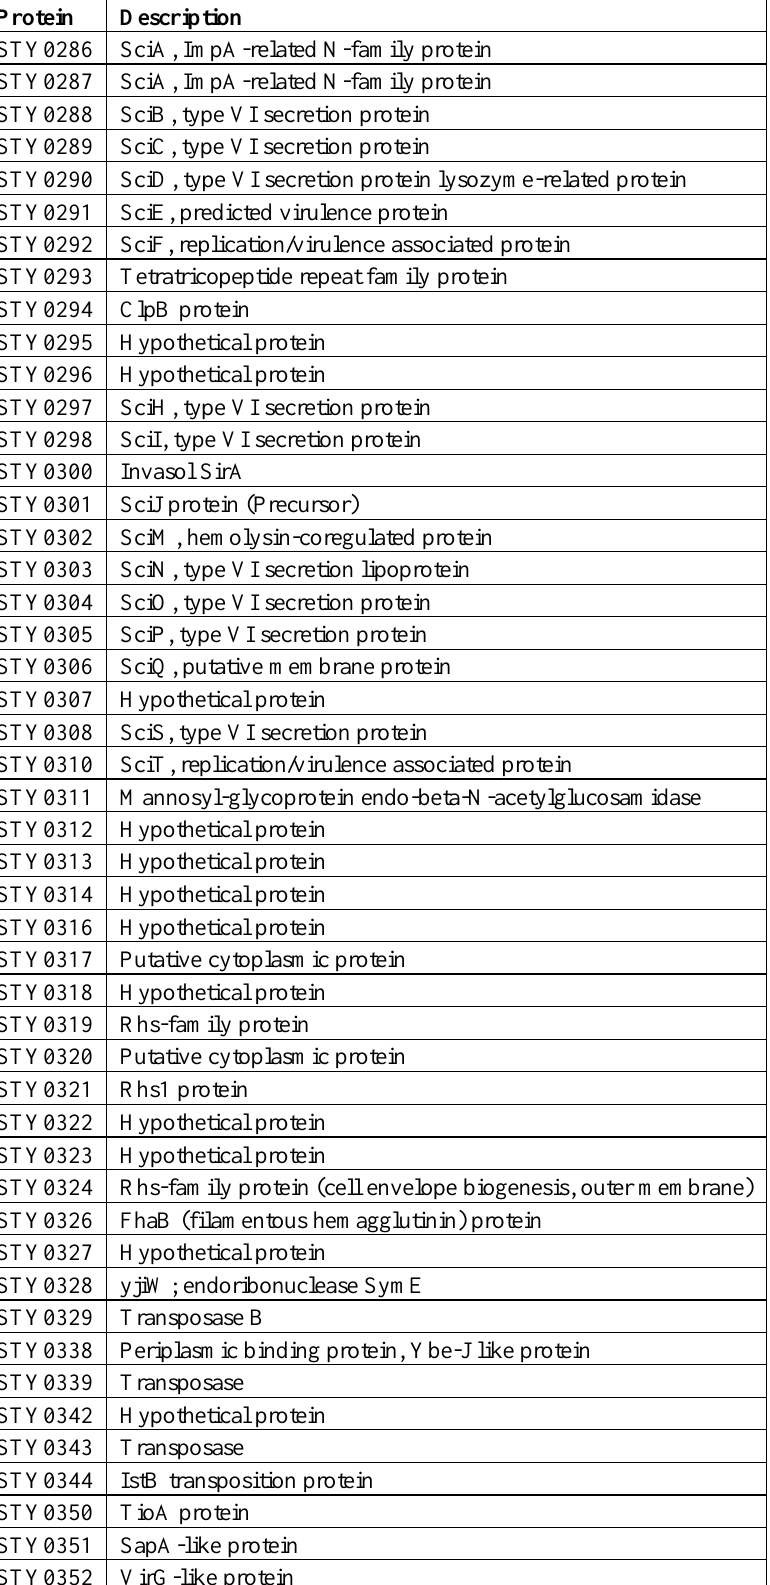
Table 1: List of proteins encoded by SPI-6. Most of the proteins are not connected and thorough bioinformatics analyses of these proteins were carried